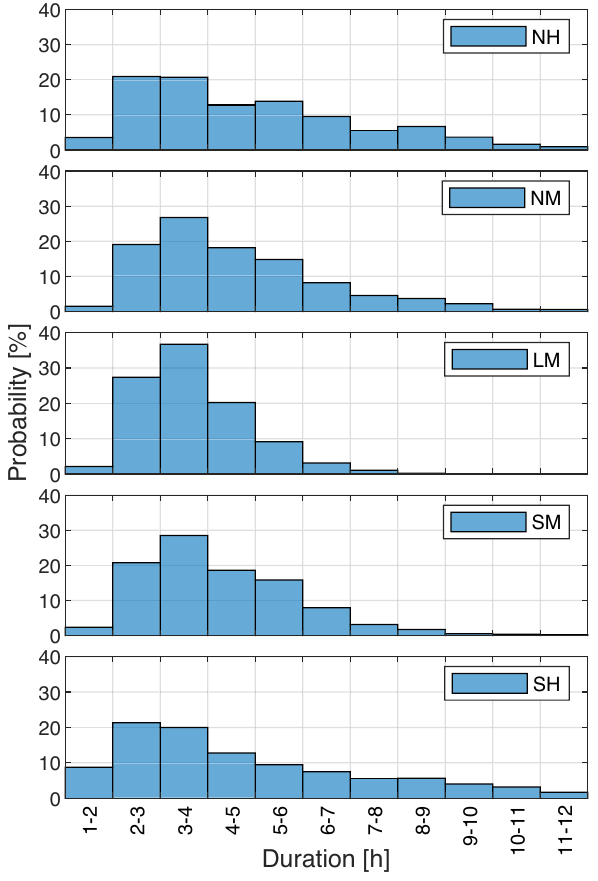
Figure 10. The duration of DDM structures in different MLAT